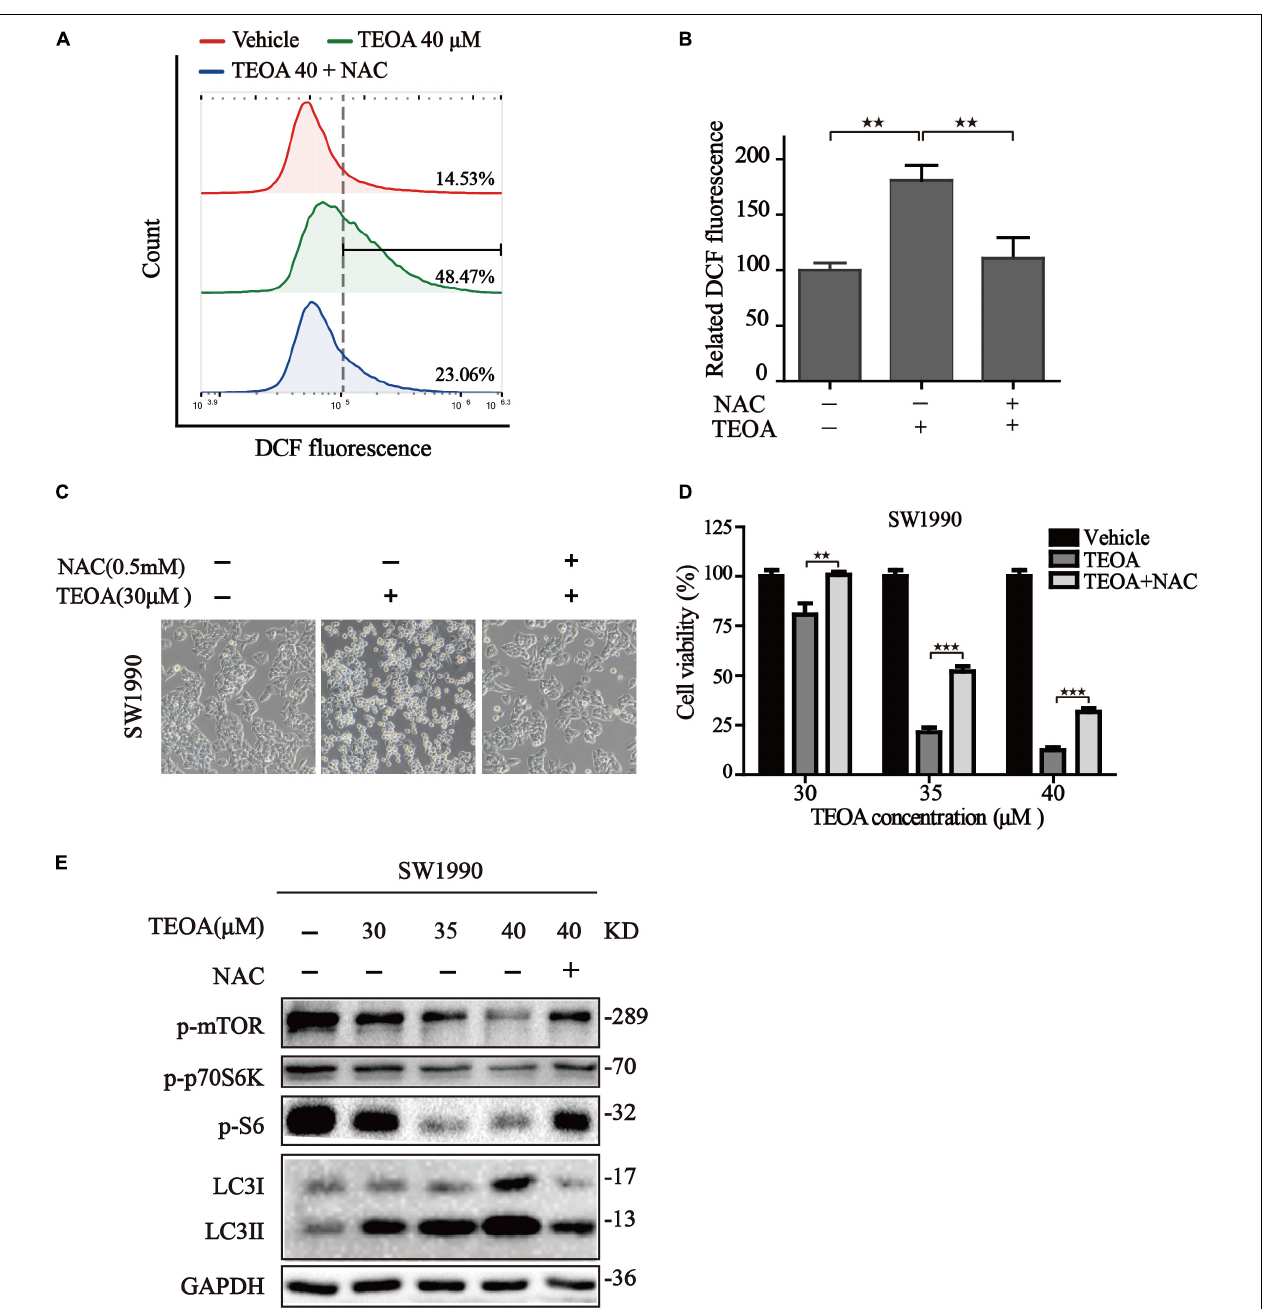
FIGURE 8 | NAC reduced the cytotoxicity of TEOA and inhibited autophagy by restoring mTOR/p70S6k signaling pathway in SW1990 cells. (A) SW1990 cells were treated with TEOA alone or in combination with 0.5 mM NAC, and then ROS levels were measured by flow cytometry after 8 h. (B) Statistical analysis of relative ROS level and the results were presented as the mean ± SD from three independent experiments. (C) SW1990 cells were treated with TEOA alone or in combination with 0.5 mM NAC. After 12 h, images were captured using optical microscope (20 × ). (D) SW1990 cells were treated with TEOA at various concentrations alone or in combination with 0.5 mM NAC for 12 h and cell viability was detected by CCK-8 assay. (E) After incubating with individual TEOA or combination with NAC for 8 h, protein expression of mTOR / p70s6k signaling pathway was determined by western blot ( (cid:70) p < 0.05; (cid:70)(cid:70) p < 0.01; (cid:70)(cid:70)(cid:70) p < 0.001, versus